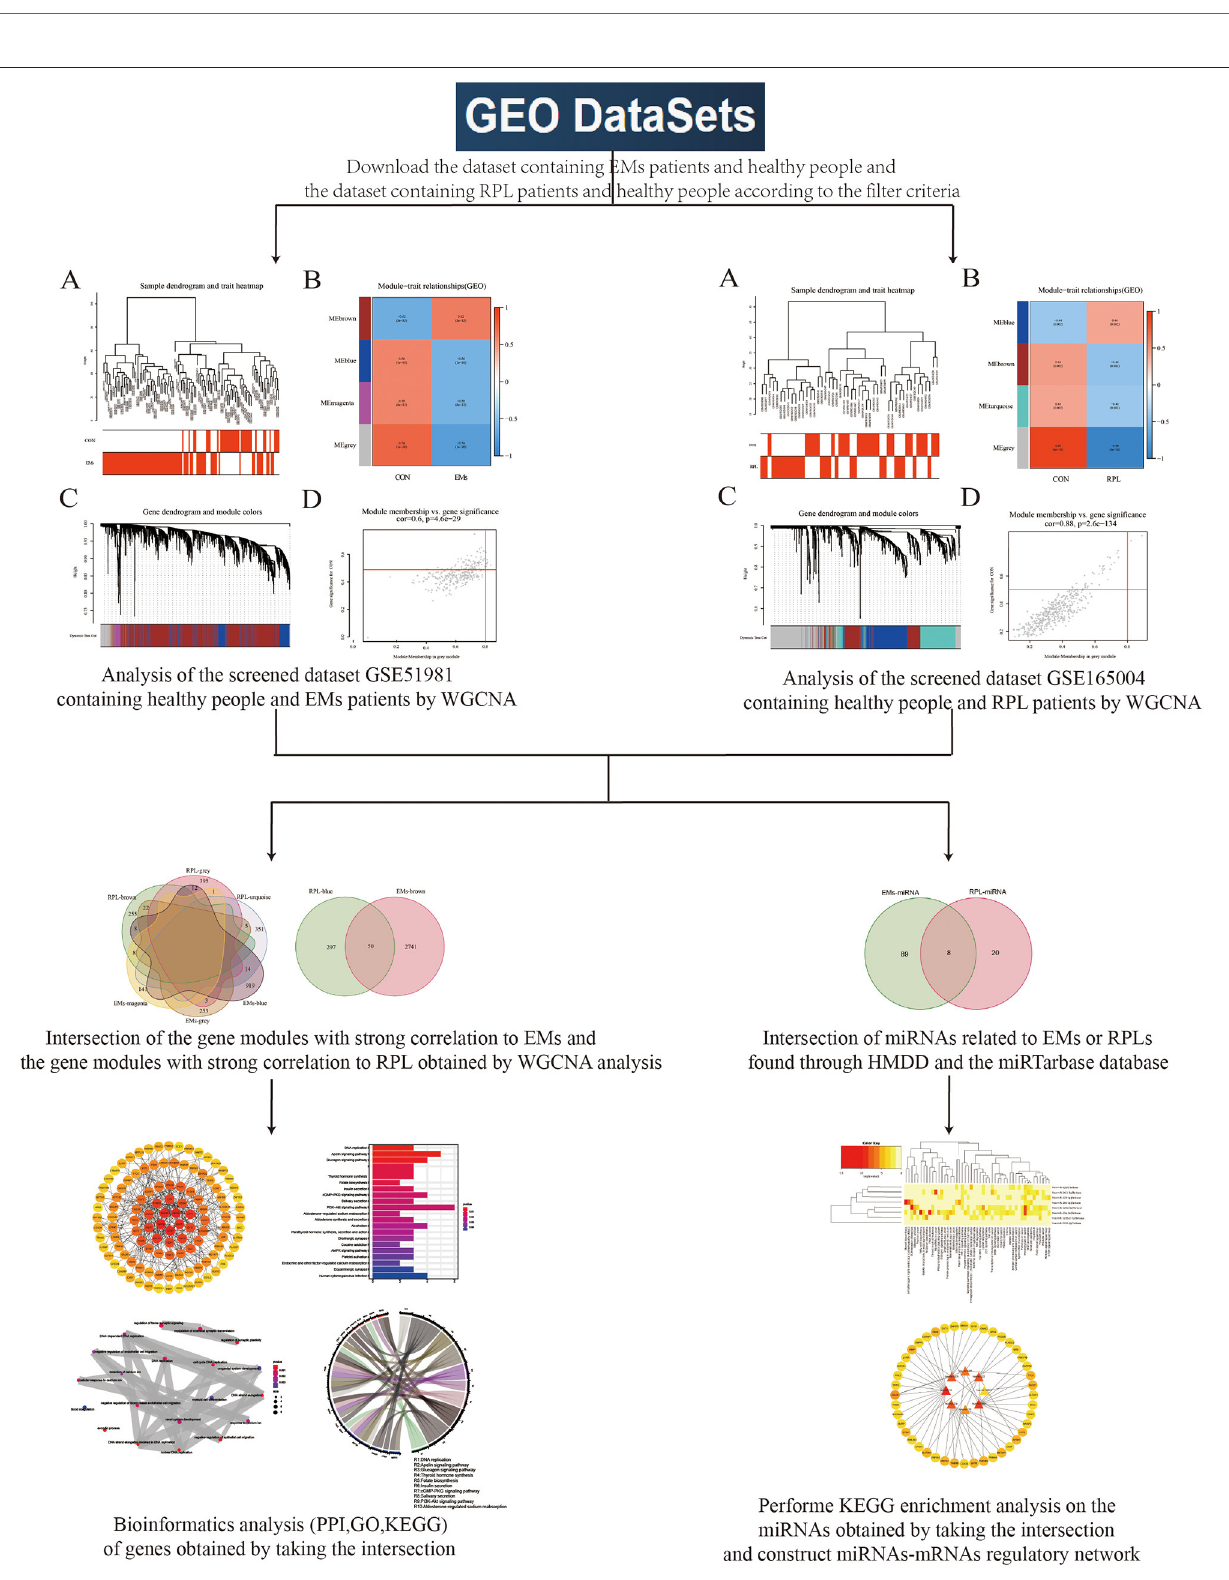
FIGURE 1 | Flowchart. This figure depicted the process of using bioinformatics methods such as WGCNA analysis to look for shared genes and biological processes between EMs and RPL.